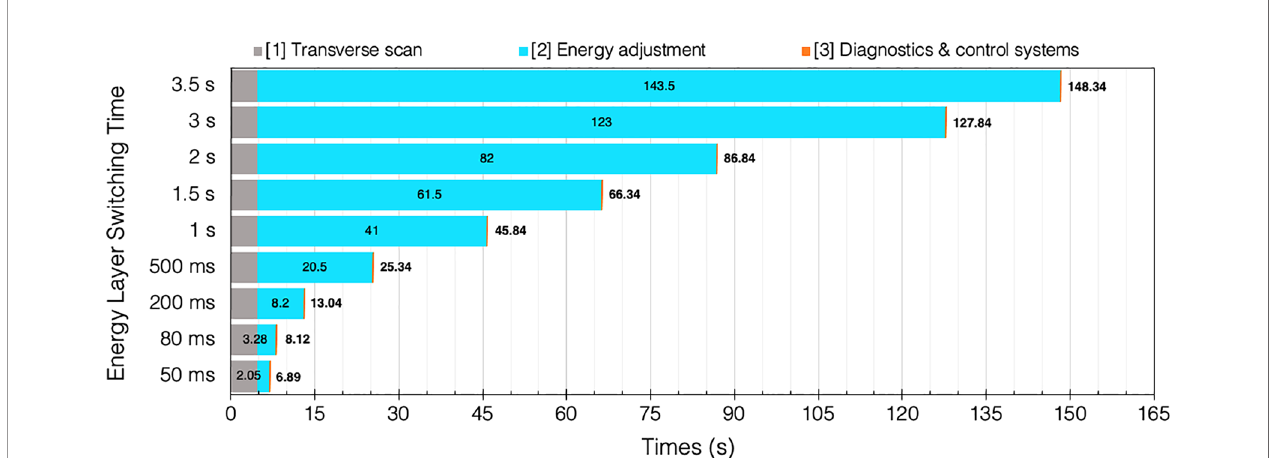
FIGURE 7 | BDT estimates and timing contributions for an example head and neck case (94) given a range of clinical ELSTs [T2]. Transvers scan [T1 = 4.76 s] and system dead times [T3 = 0.08 s] are assumed constant for each of the 42 IES.